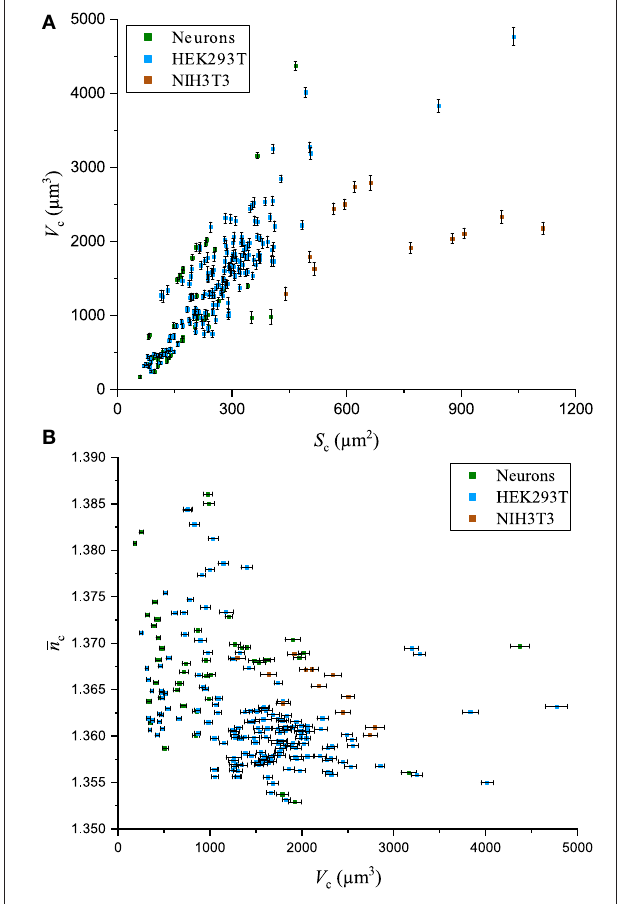
FIGURE 7 | Biophysical parameters. Various biophysical measurements for three cell types in culture, including primary neurons, and HEK293T and NIH3T3 cells. (A) Graph of V c as a function of S c , (B) Scatter of n c as a function of V c .